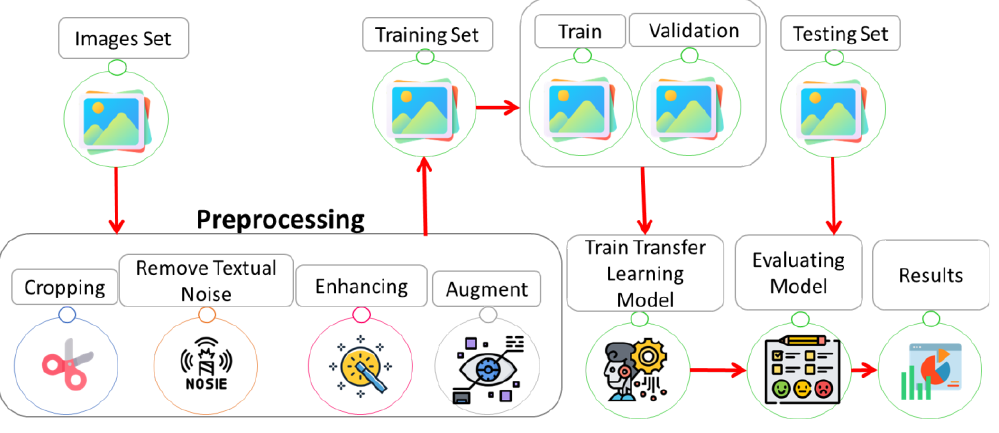
Figure 1. Proposed methodology .